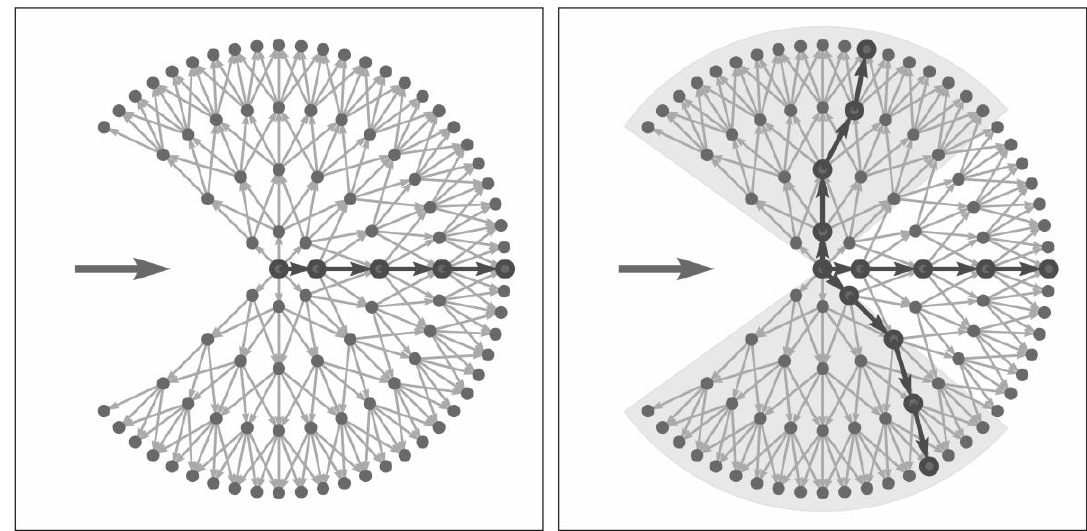
Figure 4. Main steps of movement in local graph: determine overall shortest path in graph ( left ); select shortest paths in subsections ( right ).